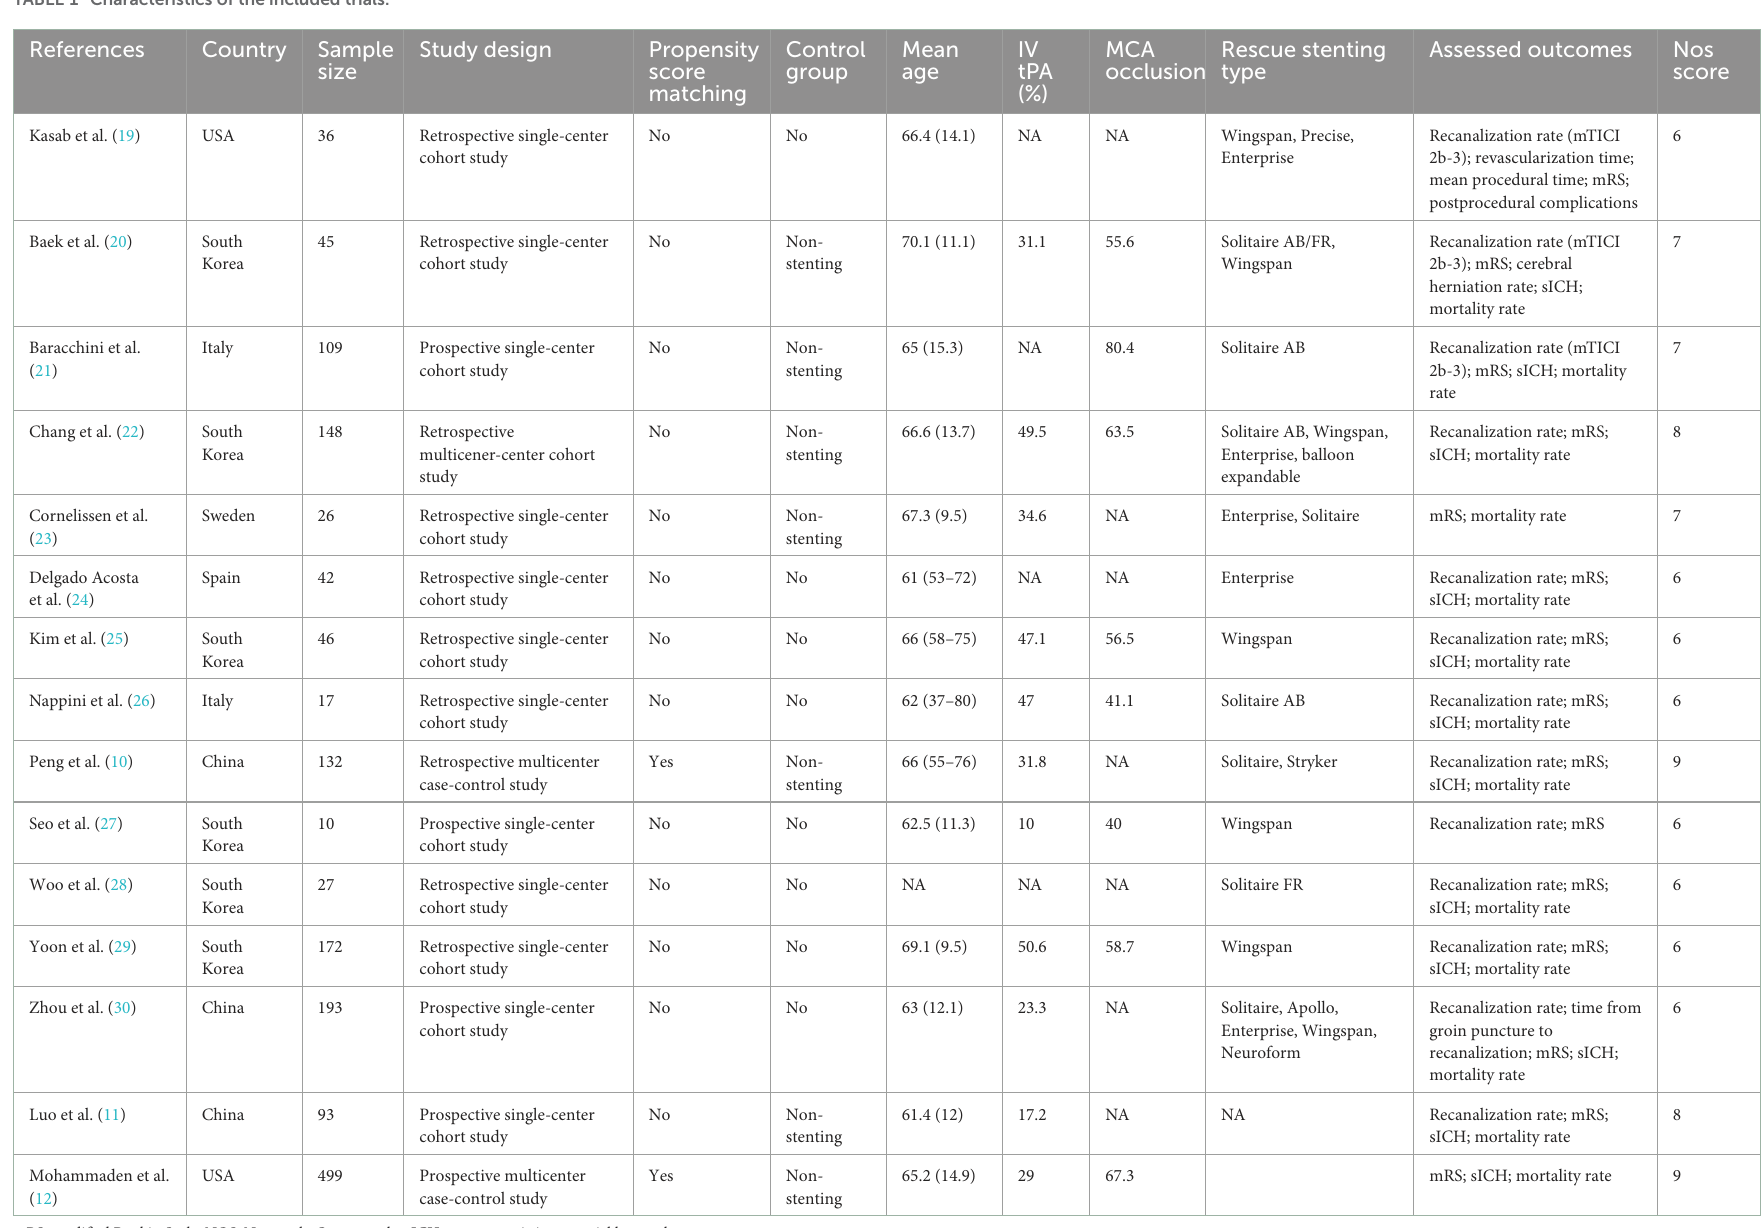
TABLE 1 Characteristics of the included